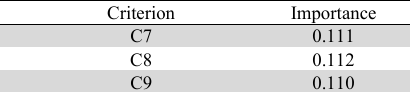
Importance of the evaluation criteria Criterion